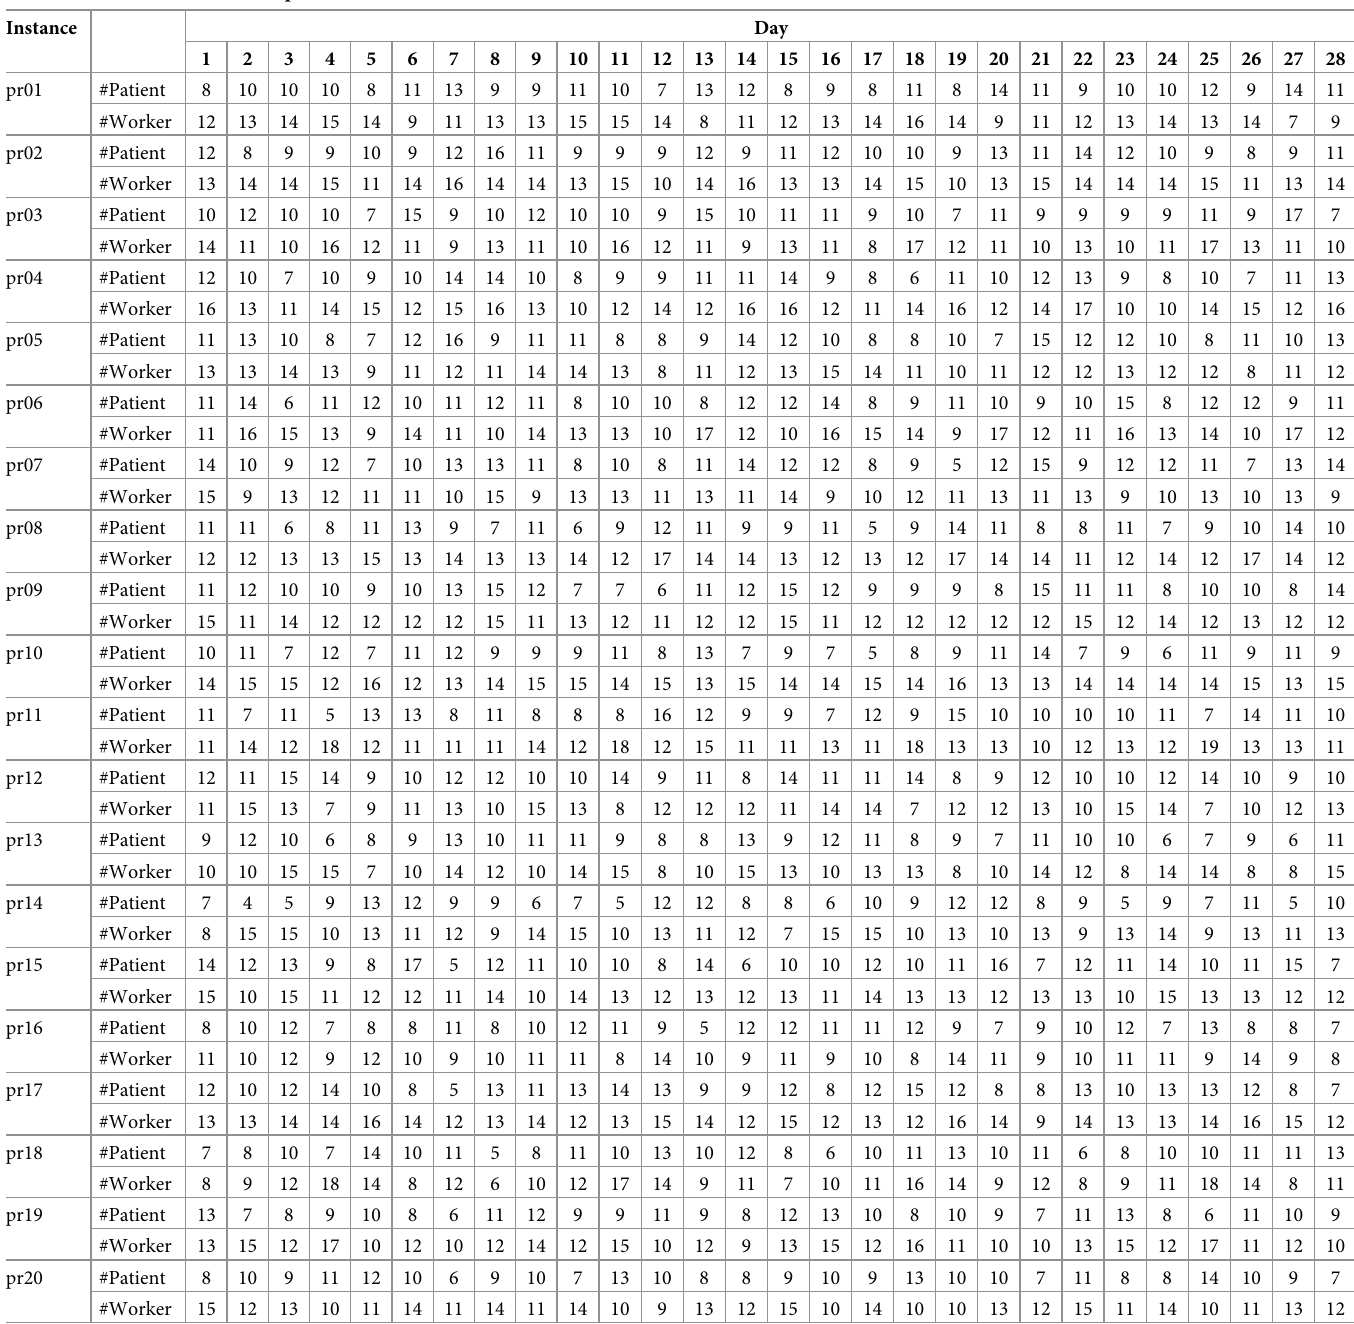
Table 4. Information of modified problem